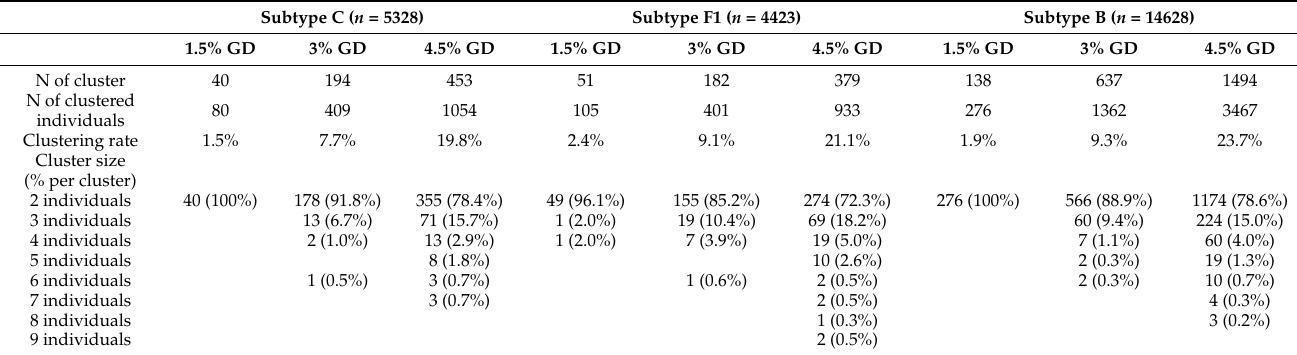
Table 1. Description of clusters identified for the HIV-1 subtypes.